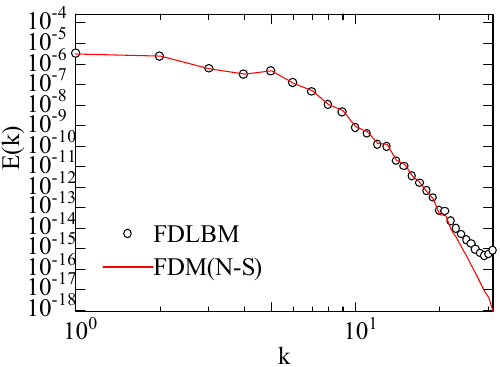
Fig. 4 Energy spectra with the DS Model for Low Reynolds number turbulence (time step =